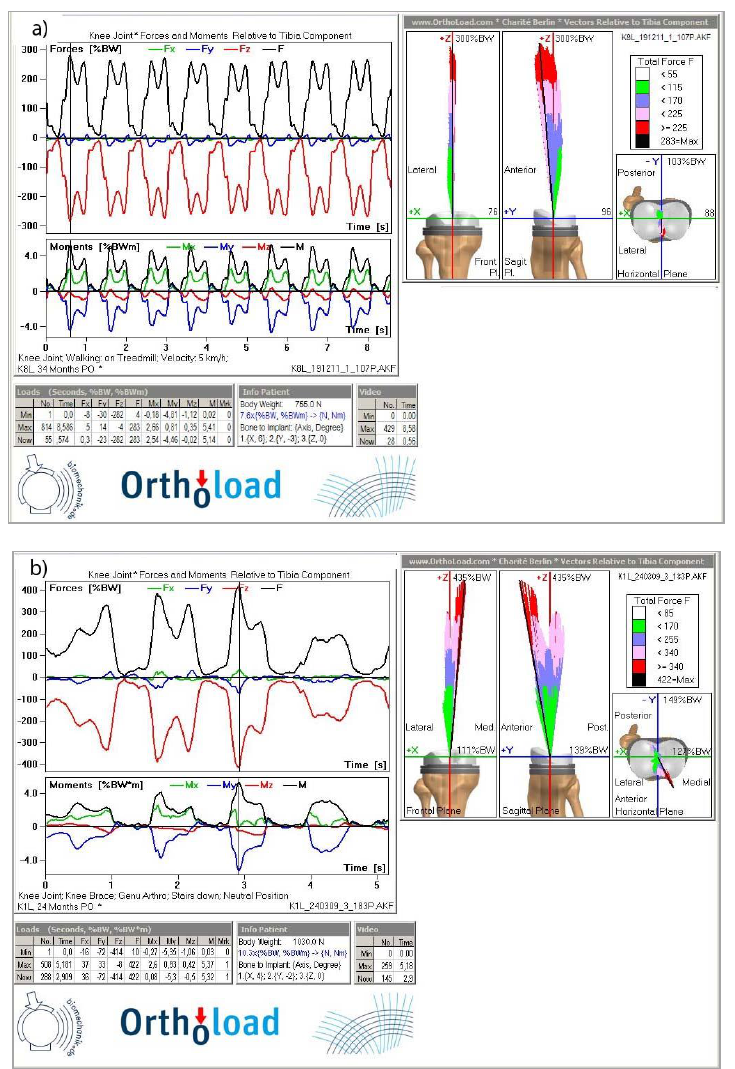
Figure 1. Effect of forces acting on the knee joint: ( a ) walking at the speed of 5 km/h ( b ) going downstairs [29,30]. downstairs